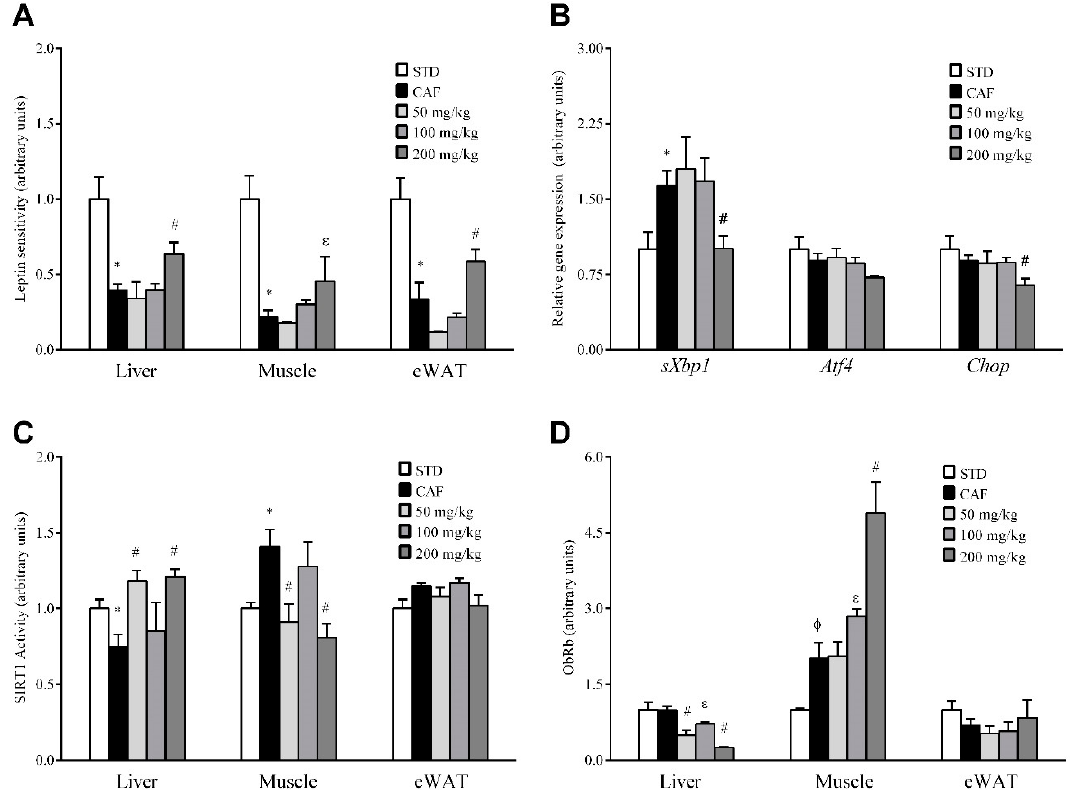
Figure 3. Leptin sensitivity and signaling. The rats were fed the STD or CAF diet for 9 weeks. Then, the STD and CAF rats were treated orally with RSV (50, 100 or 200 mg per kg of body wt) or vehicle for 3 weeks. ( A ) The leptin sensitivity index. ( B ) Gene expression of ER-stress markers in eWAT. ( C ) SIRT1 activity. ( D ) WB results for ObRb. Data are expressed as the mean ± SEM, n = 6. * p < 0.05 and φ p < 0.1, Student’s t -test comparing the CAF group with the STD group. # p < 0.05 and ε p < 0.1,